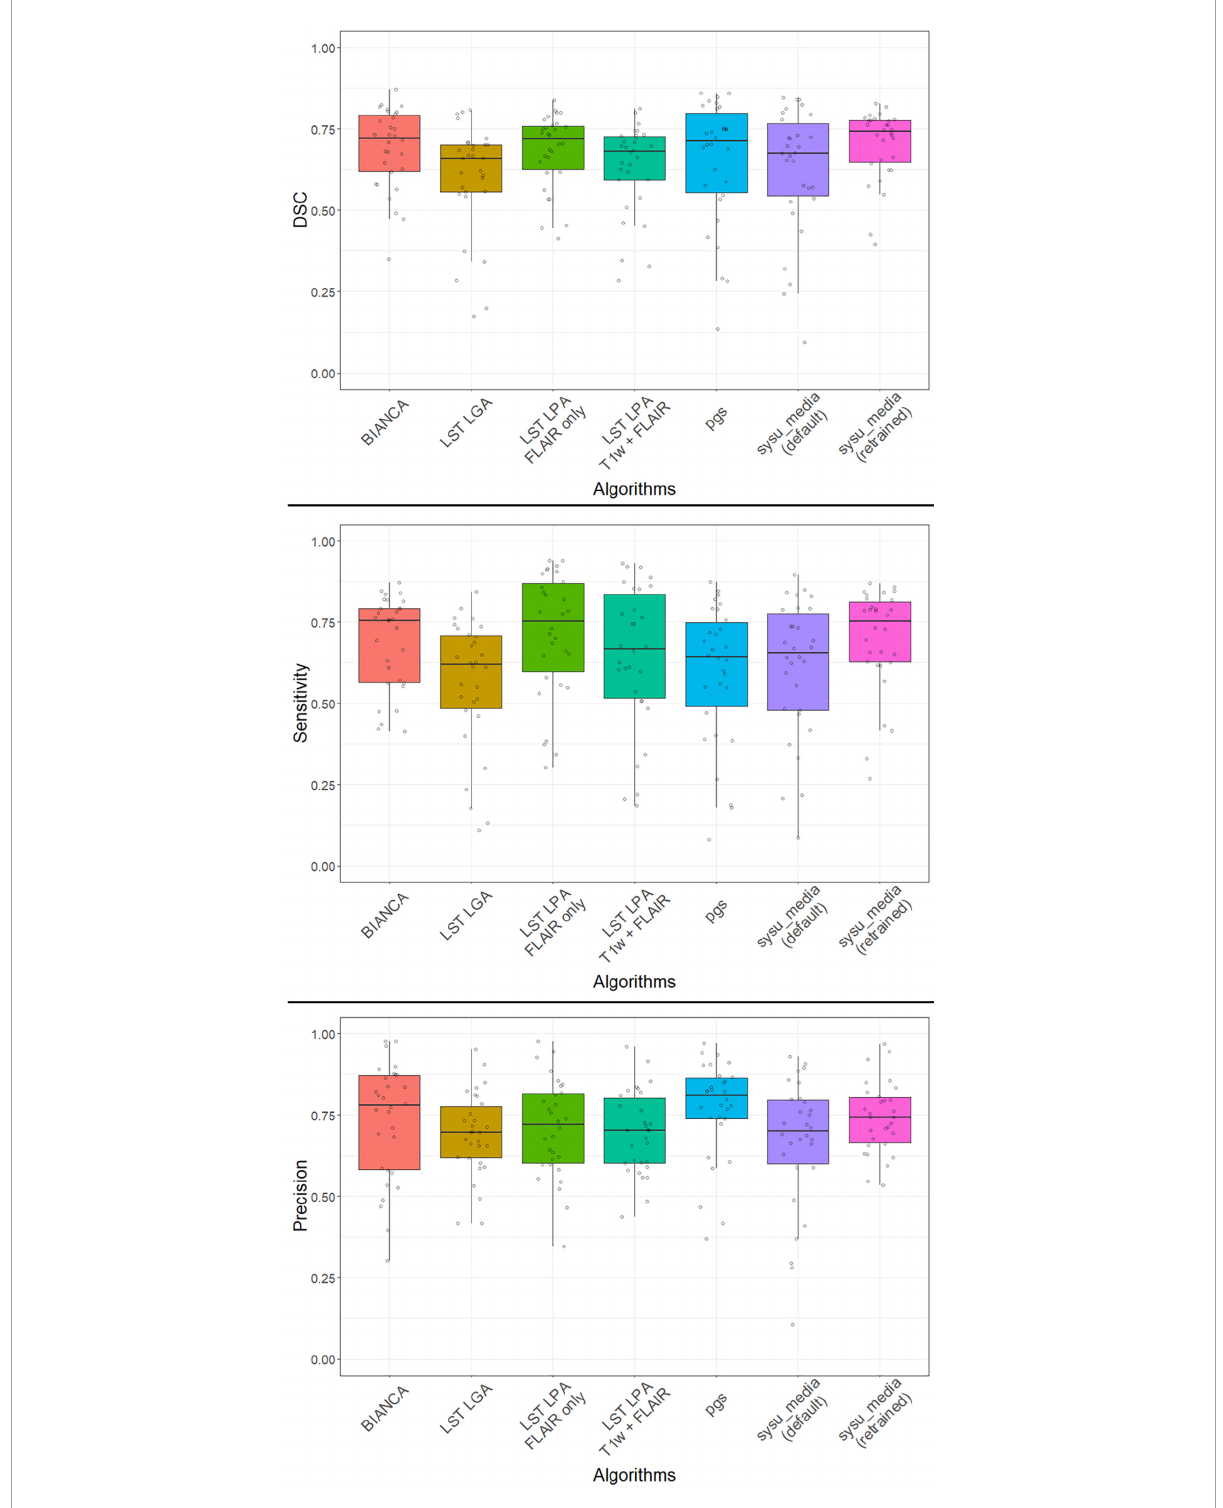
FIGURE1 Distribution of performances of all algorithms with DSC (top) , sensitivity (middle) , and precision (bottom) at volume level. The median, the 25–75 percentiles and all individual values are represented. DSC, Sørensen-Dice similarity coefficient; T1w, T1-weighted image; FLAIR, fluid-attenuated inversion recovery image; BIANCA, brain intensity abnormality classification algorithm; LST LGA/-LPA, lesion segmentation toolbox for SPM using lesion growth algorithm/lesion prediction